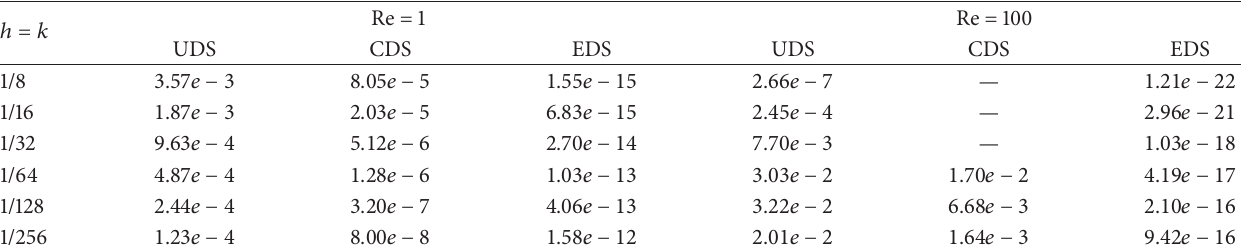
Table 1: Maximum absolute errors with Re = 1 (left) and Re = 100 (right), Example 7.